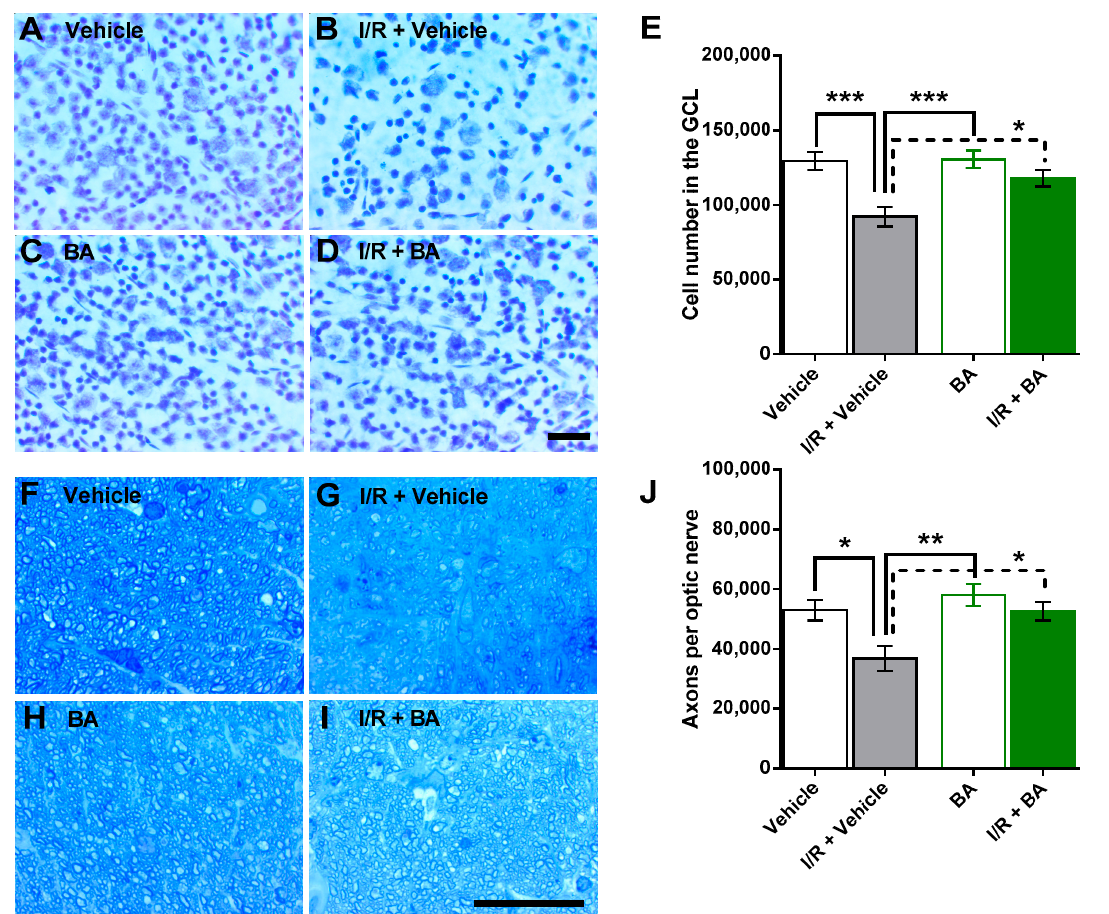
Figure 1. Total cell number in the ganglion cell layer (GCL) of the retina and axon number in the optic nerve. ( A – D ) Representative pictures of cells in the GCL stained with cresyl blue. Scale bar = 30 µ m. ( E ) I/R markedly reduced the total cell number in the GCL in vehicle-treated mice but not in betulinic acid (BA)-treated mice (*** p < 0.001; * p < 0.05; n = 8 per group). ( F – I ) Representative pictures of optic nerve axons stained with toluidine blue. Scale bar = 30 µ m. ( J ) I/R reduced axon number in the optic nerve in vehicle-treated mice but not in BA-treated mice (** p < 0.01; * p < 0.05; n = 8 per group).